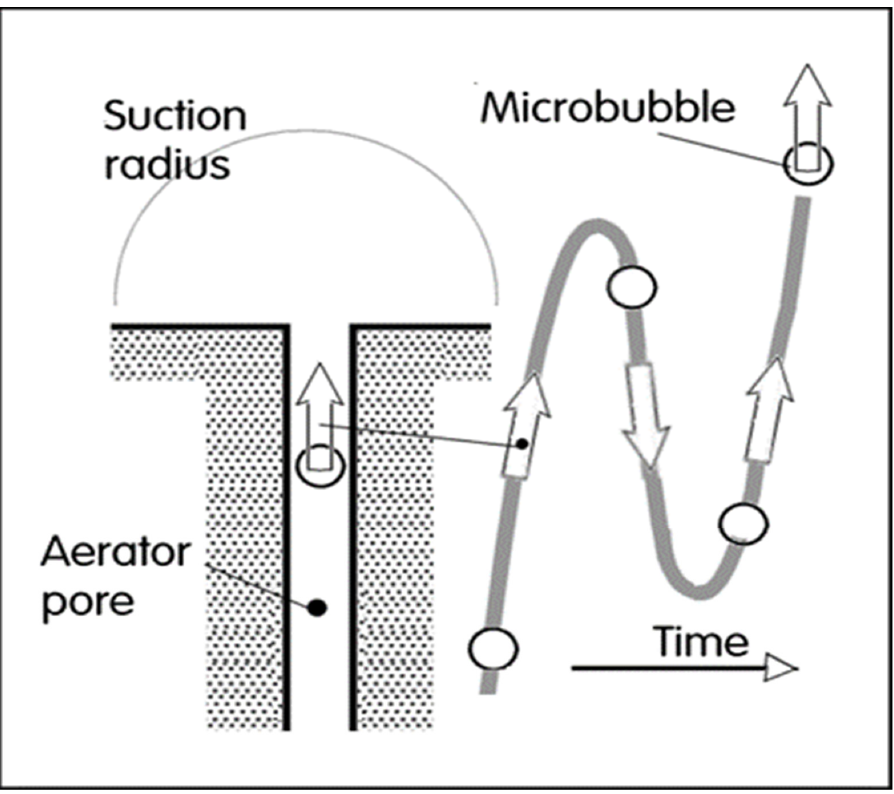
Figure 10. Mechanism of preventing the conjunction in the aerator exit in flow with the oscillator. The microbubbles within the suction radius are in a part of the cycle turned back into the aerator pore—so that they get mutually separated by distance so large that their conjunction is avoided.